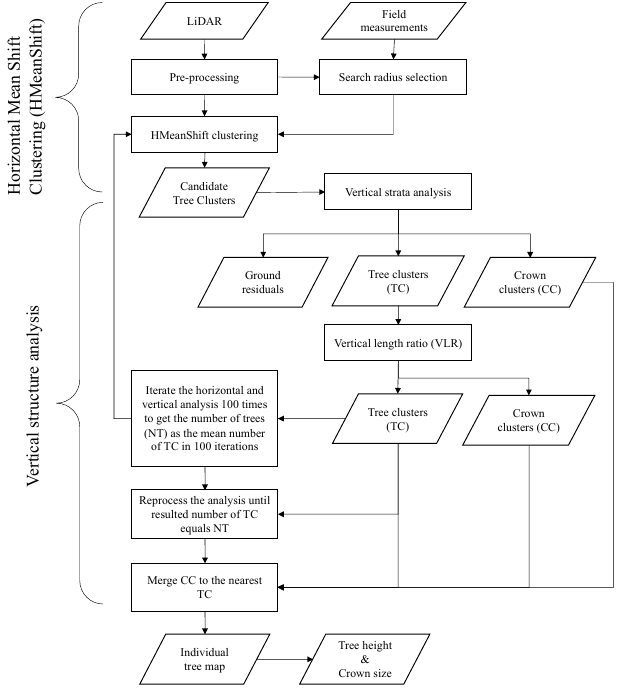
Figure 3. Flowchart of the stepwise tree detection approach.